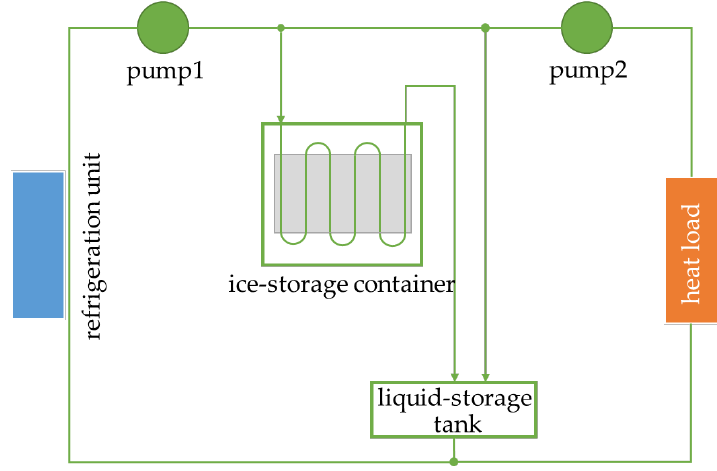
Figure 1. Schematic of the cyclic experimental system.